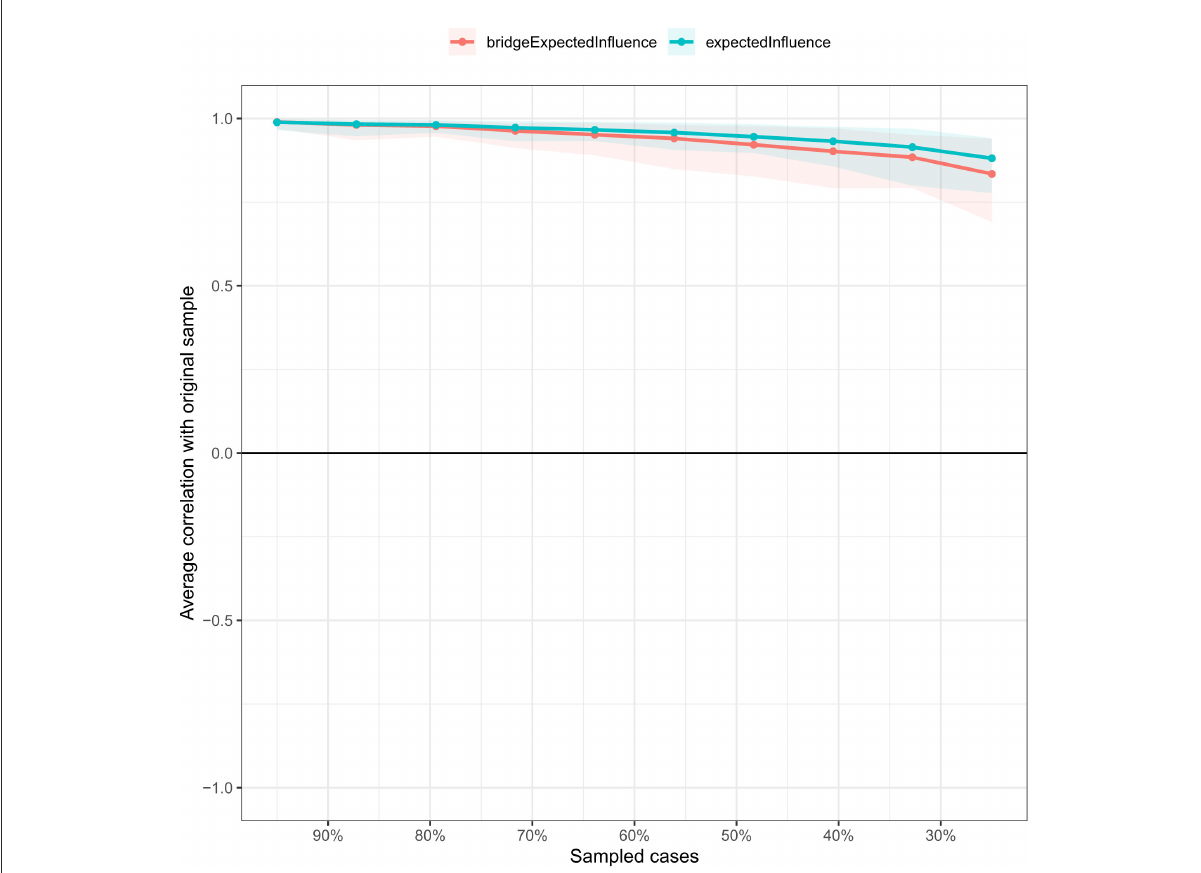
FIGURE4 The stability of the depression-anxiety network. The stability of central and bridge expected influence by case-dropping bootstrap. The CS-C for the node and bridge expected influence was 0.672 and 0.75, respectively.